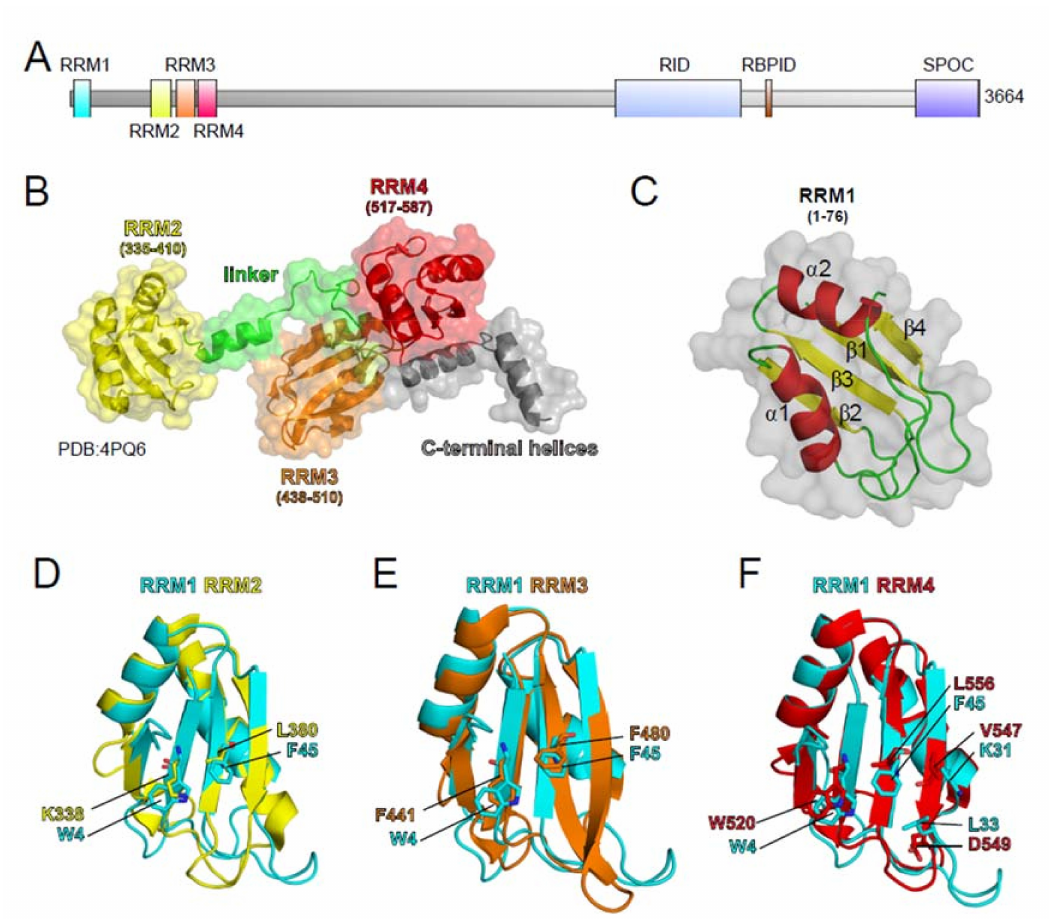
Figure 3. Structure modeling of SHARP RRM1. ( A ) Schematic representation of SHARP protein domains: RRM1 (aa 6 to 81), RRM1 (aa 335 to 410) RRM3 (aa 438 to 510), RRM4 (aa 517-587), Receptor Interaction Domain (RID, aa 2201 to 2707), RBP-J Interaction Domain (RBPID, aa 2776 to 2813), Spen Paralogue and Orthologue C-Terminal Domain (SPOC, aa 3417 to 3664). ( B ) Crystal structure of SHARP RRMs 2 to 4 (aa 335 to 620) from PDB: 4PQ6 [183]. ( C ) Homology model of SHARP (amino acids 6 to 81, accession NP_055816.2) performed with swissmodel (https://swissmodel.expasy.org/ (accessed date 14 January 2021). The model shows the typical β 1- α 1- β 2- β 3- α 2- β 4 topology of RRMs: Four antiparallel β sheets (yellow) framed from two α helices (red). Loops are shown in green. ( D – F ) Structural alignment of RRM1 (cyan) with RRM2 ( D , yellow), RRM3 ( E , orange), and RRM4 ( F , red). Amino acids typically having contact with nucleic acids are highlighted. All of the structures and alignments were performed with PyMol